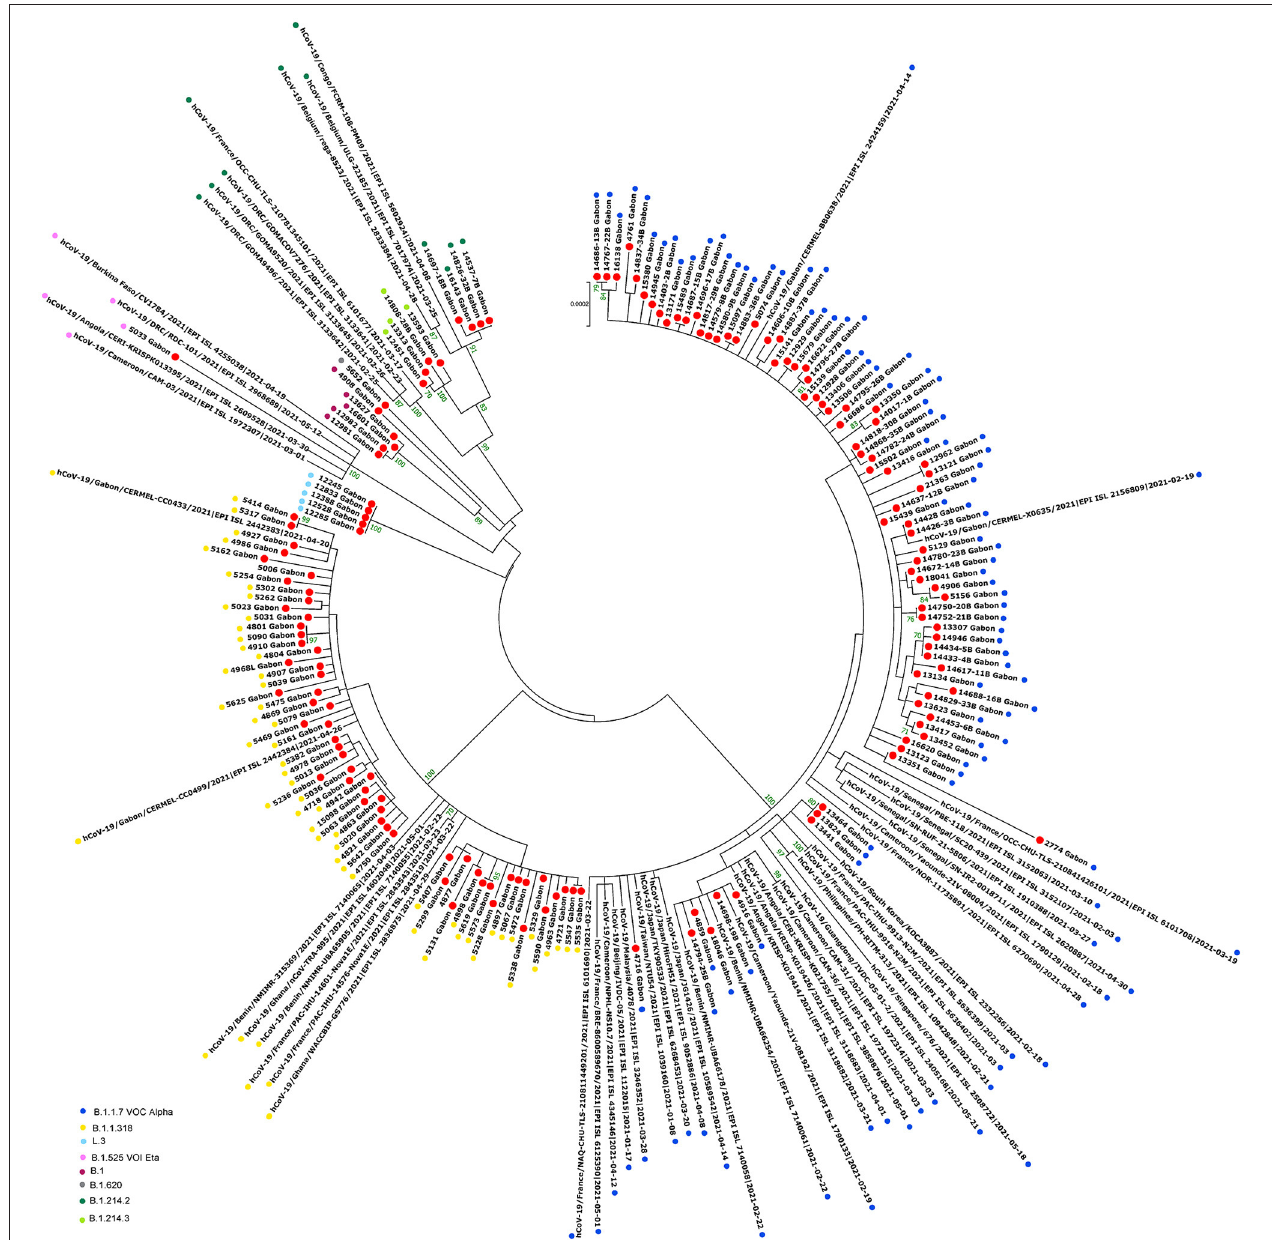
FIGURE 8 | Molecular Phylogenetic analysis by Maximum Likelihood method using 154 sequences from strains circulating during the second wave in Gabon and 51 SARS-CoV-2 sequences available in GISAID. The evolutionary history was inferred by using the Maximum Likelihood method based on the Jukes-Cantor model. The tree with the highest log likelihood ( − 47967.94) is shown. Initial tree(s) for the heuristic search were obtained automatically by applying Neighbor-Join and BioNJ algorithms to a matrix of pairwise distances estimated using the Maximum Composite Likelihood (MCL) approach, and then selecting the topology with superior log likelihood value. The tree is drawn to scale, with branch lengths measured in the number of substitutions per site. The analysis involved 205 nucleotide sequences. All positions with < 80% site coverage were eliminated. That is, fewer than 20% alignment gaps, missing data, and ambiguous bases were allowed at any position. There were a total of 28844 positions in the final dataset. Evolutionary analyses were conducted in MEGA7. The red circles correspond to the genomes identified in this study.